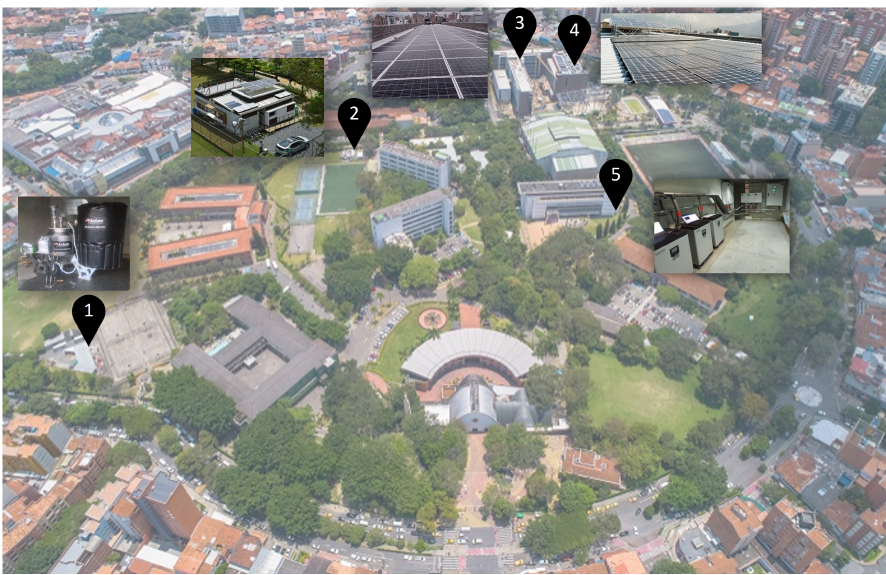
Figure 1. Some of the UPB campus microgrid resources and locations. Medellin, Colombia.